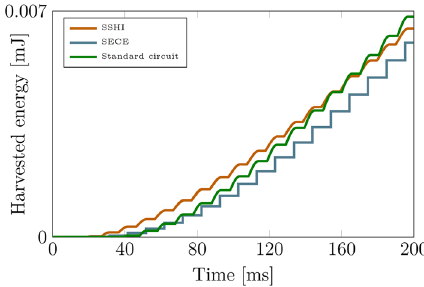
Fig. 11 Harvested energy E of the bimorph PVEH with stand- ard, SSHI and SECE circuit under a harmonic base acceleration of 9.81 m/s 2 and a frequency of 48.7